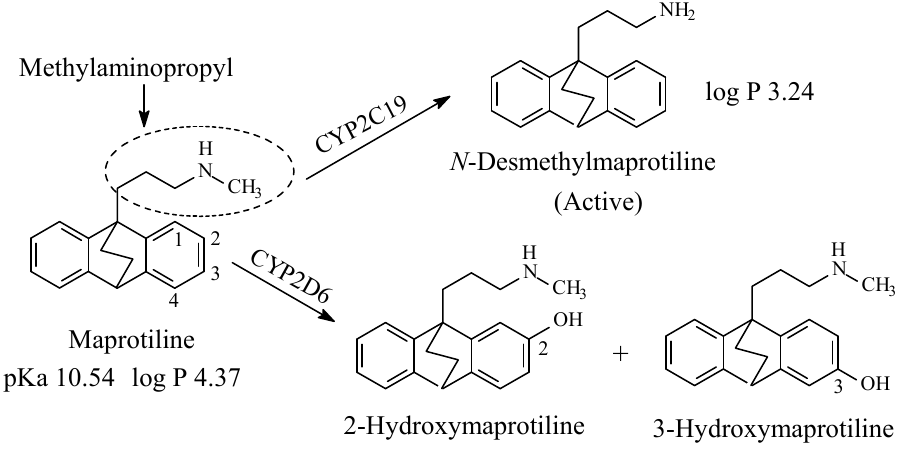
Figure 8. Major metabolic pathways of maprotiline.